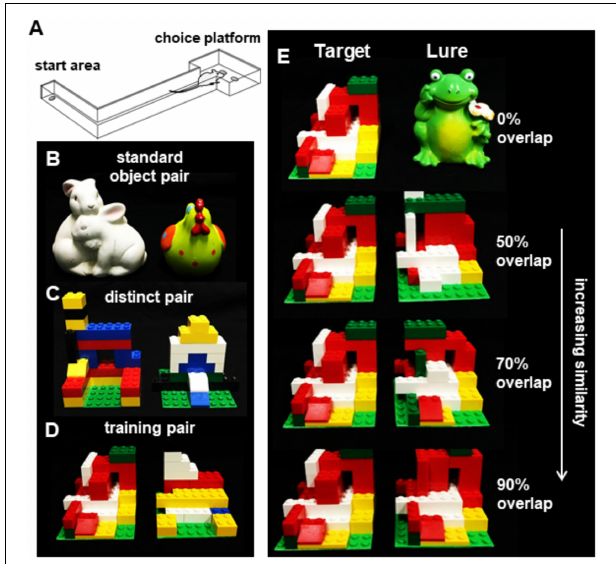
FIGURE 1 | The rodent mnemonic discrimination task. (A) Schematic of the apparatus used for training and testing discrimination in rats. (B) Object pairs used for standard (no overlap) object discrimination pre-training. (C) Object pairs used for LEGO block object discrimination pre-training. (D) The LEGO block object pair used to train rats to identify the target object (left) prior to and following surgery. (E) The target object shown next to the (from top) 0, 50, 70, and 90% overlap lure